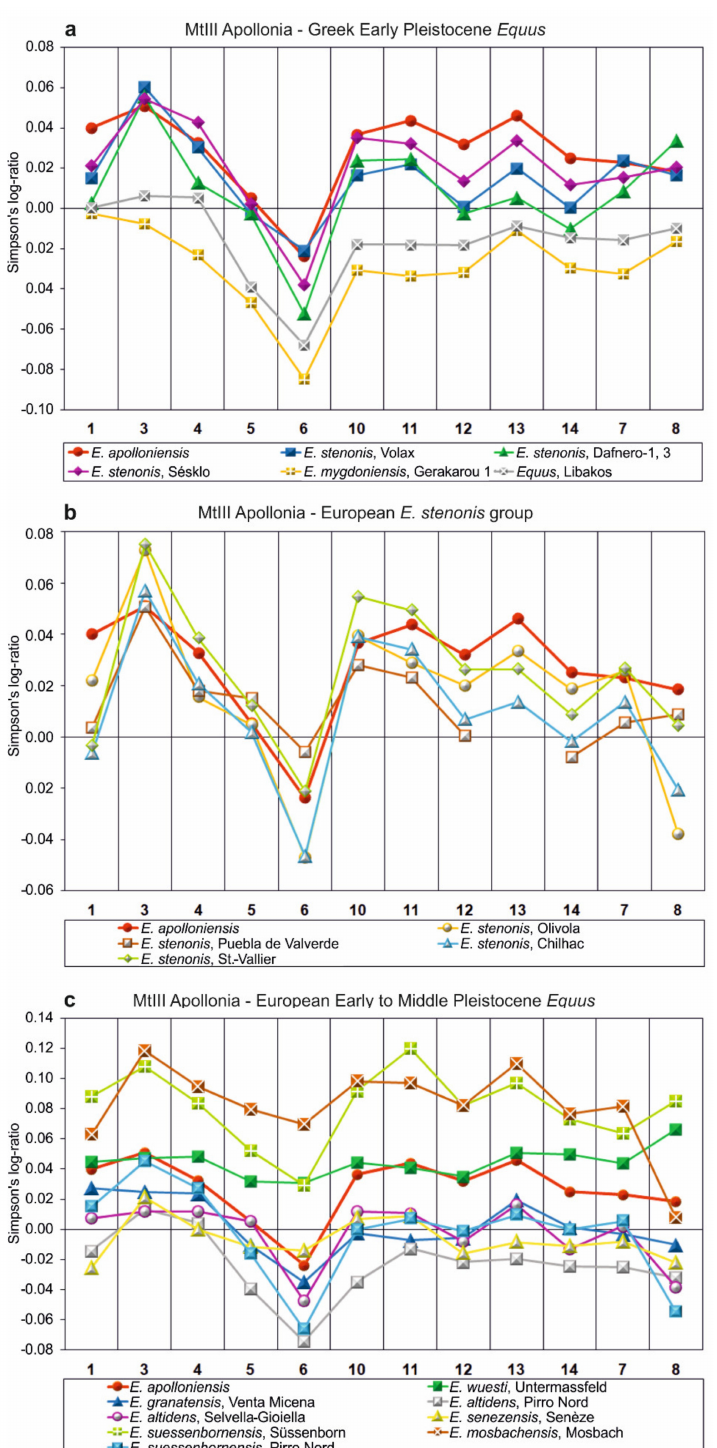
Figure 10. Simpson’s log-ratio diagrams comparing the dimensions of the third metatarsal of E. apolloniensis with ( a , b ) Greek and European E. stenonis and ( c ) other Early/Middle Pleistocene horses. Standard: Equus grevyi [69]. Data from [61–65,80] and personal dataset. Definitions of meas., see Supplementary